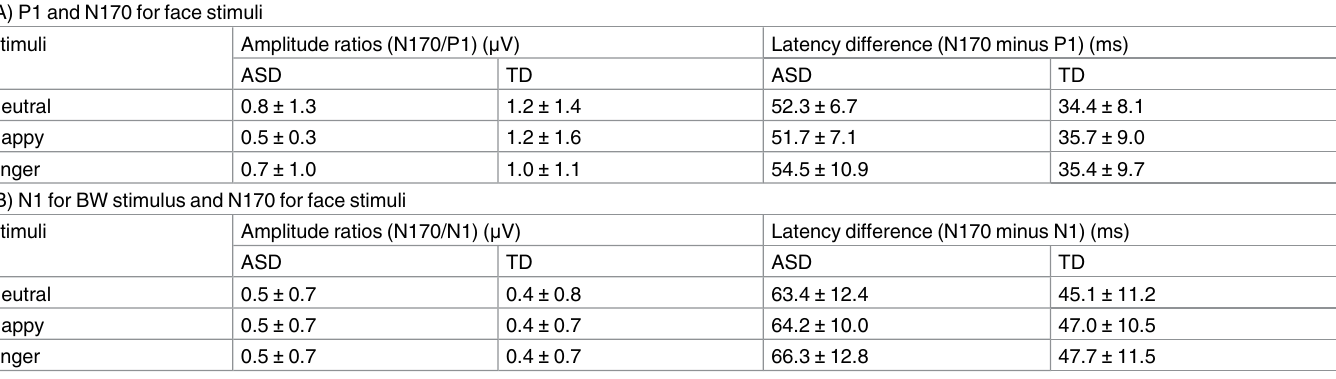
Table 3. Comparison between lower (V1) and higher (V4) cortical responses in ASD and TD adults. (A) P1 and N170 for face